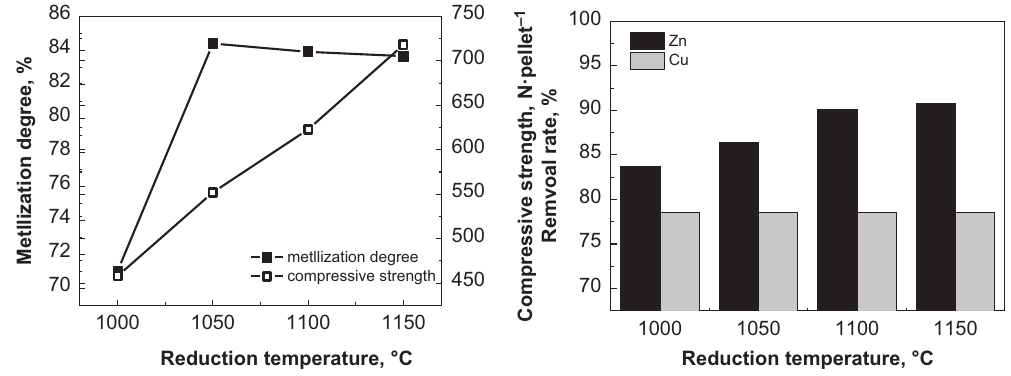
Figure 8: Effect of reduction temperature on metallization, compressive strength and removal rate of Zn and Cu.